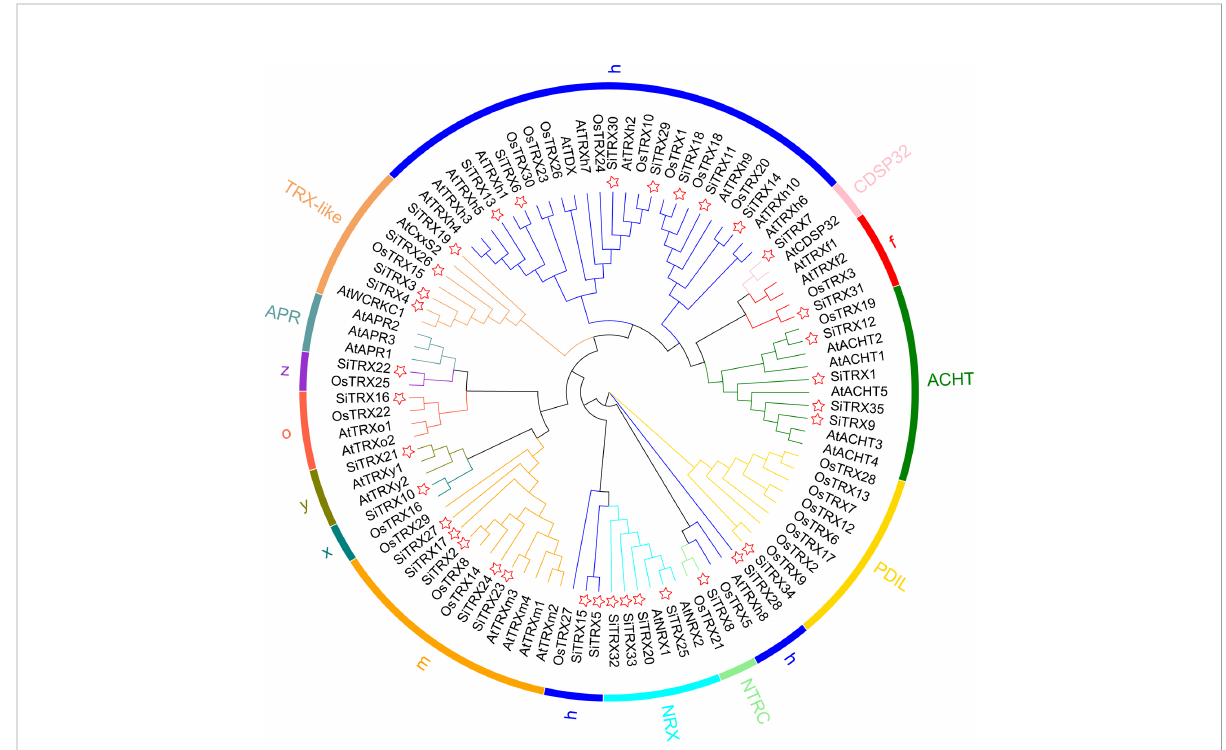
FIGURE 1 Phylogenetic relationships of TRX family proteins in foxtail millet, Arabidopsis and rice. The phylogenetic tree was constructed using the maximum likelihood method in the MEGA 7.0 software. The red star represents SiTRX. The species ’ acronyms are shown before each TRX- protein name: Si, Setaria italica ; At, Arabidopsis thaliana ; Os, Oryza sativa